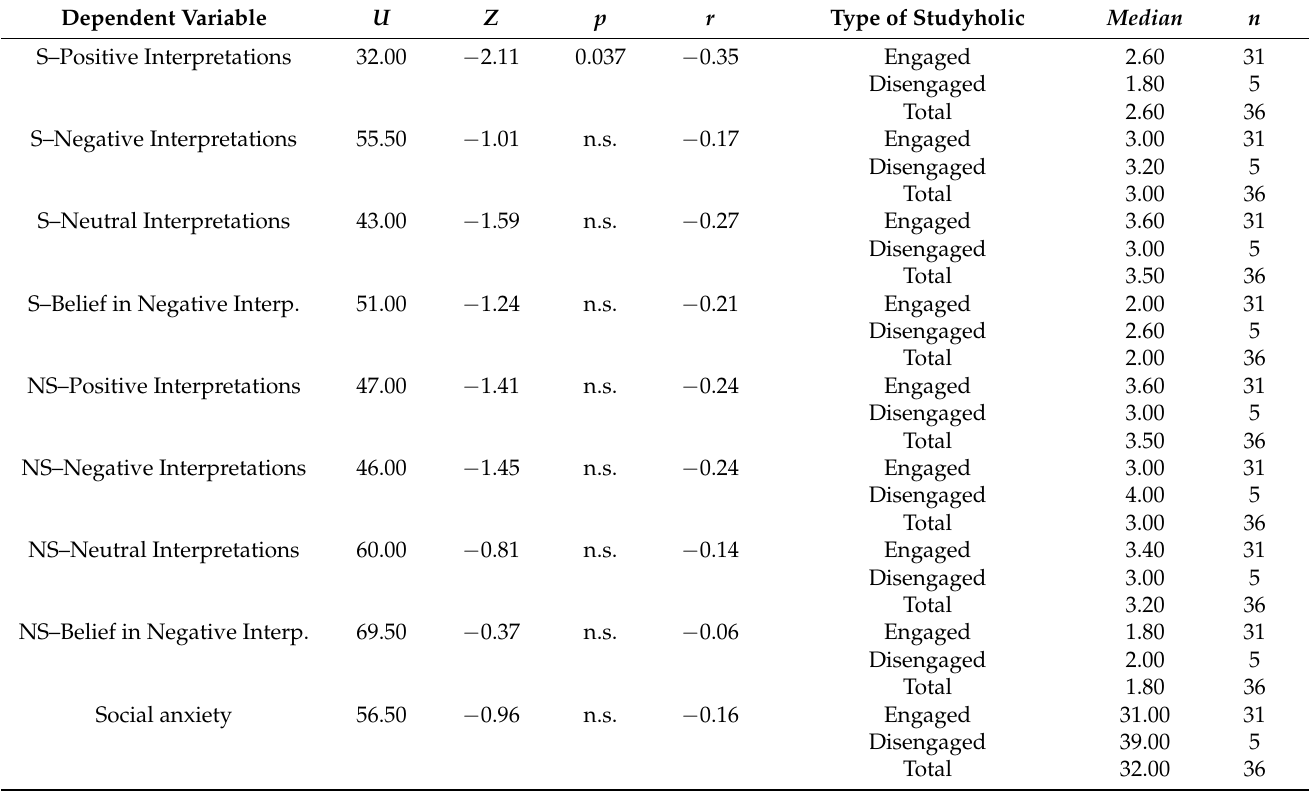
Table 5. Mann-Whitney tests for Studyholism antecedents and outcomes by Studyholic